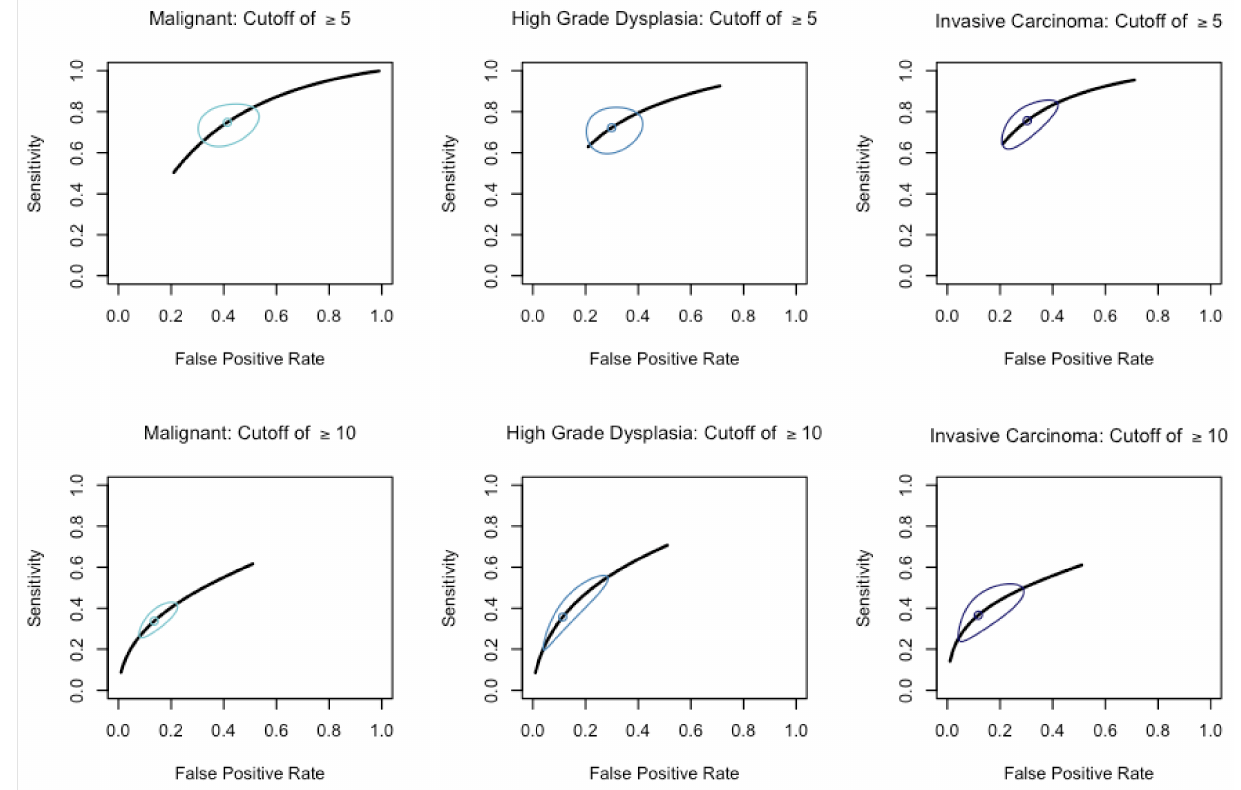
Figure 3. Summary receiver operating characteristic (SROC) curves for the bivariate diagnostic tests. Dot is point estimate that represents estimated pooled sensitivity/1-specificity for the included studies. Circle represents the confidence interval around the point